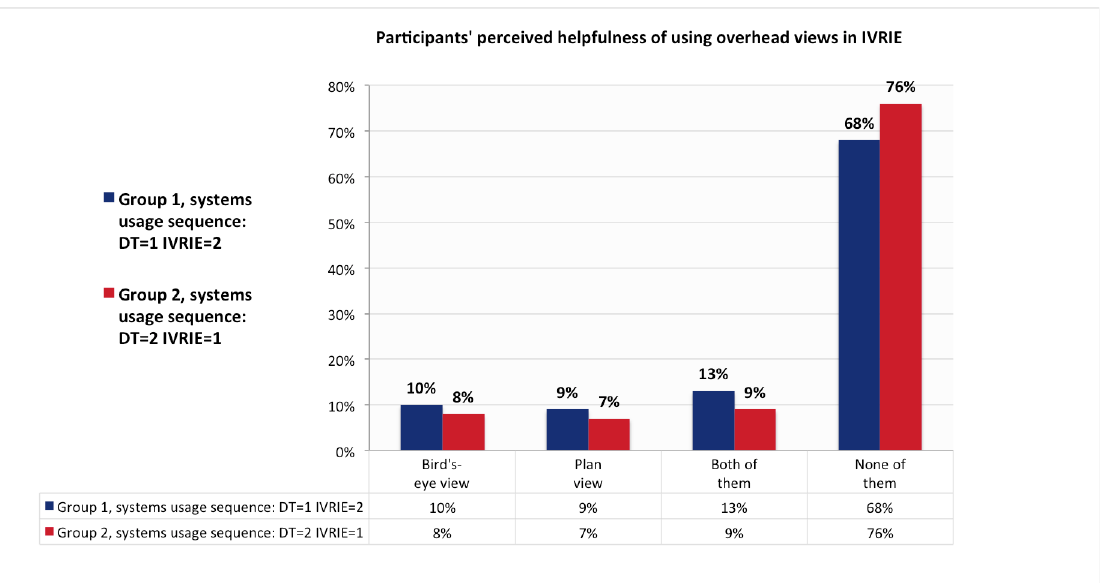
Figure 9 . Differences in perceived helpfulness of the overhead view in IVRIE for participants in both groups.